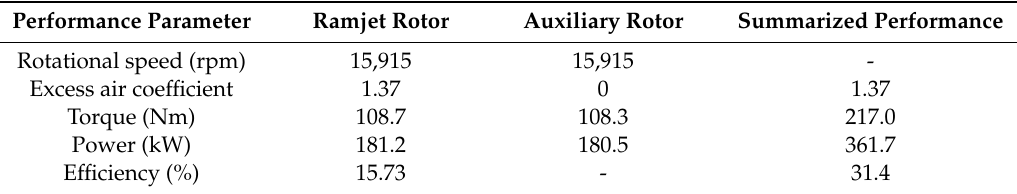
Table 1. Estimated engine